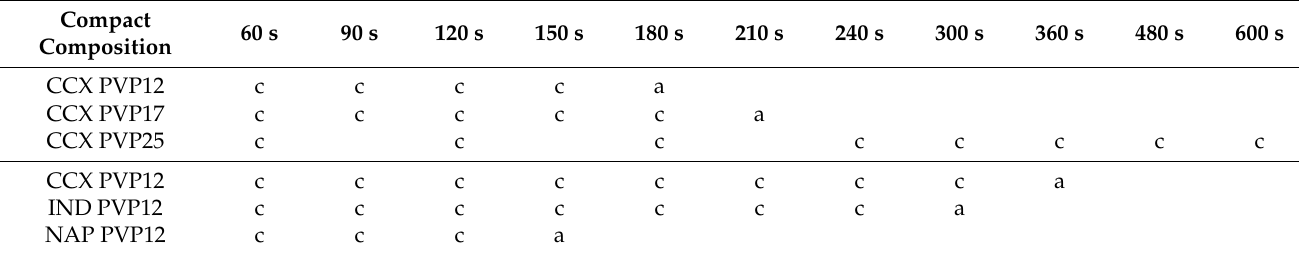
Table 2. Exposure times of compacts to laser radiation and the solid state of the drug determined by XRPD; c: residual crystallinity; a: fully amorphous. The experiments for the upper three rows were performed at a laser intensity of 1.52 W/cm 2 . The experiments for the lower three rows were performed at a laser intensity of 1.02 W/cm 2